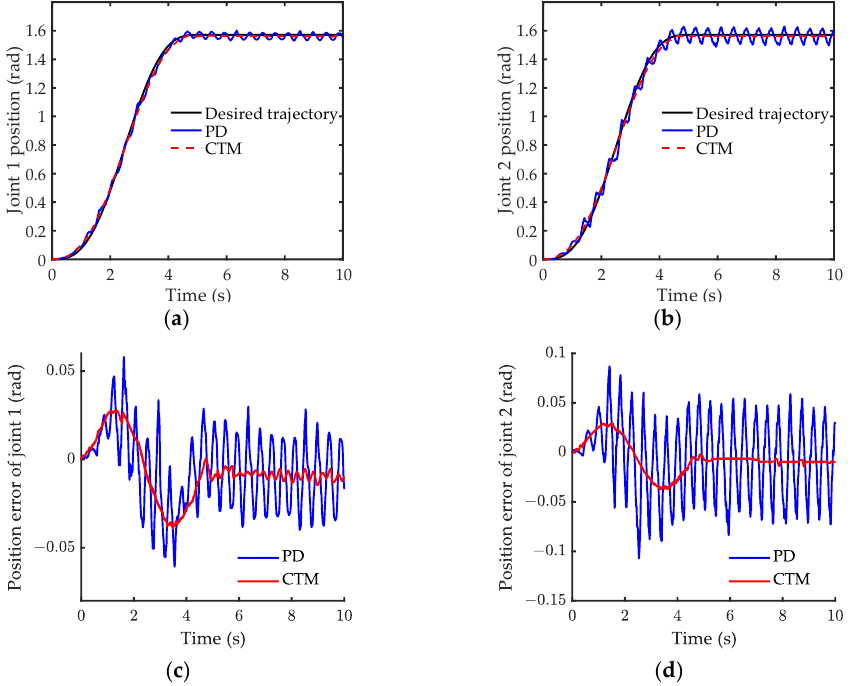
Figure 19. Experiment result of joint 1 position for case 1: ( a ) joint 1 position; ( b ) joint 2 position; ( c ) position error of joint 1; ( d ) position error of joint 2.